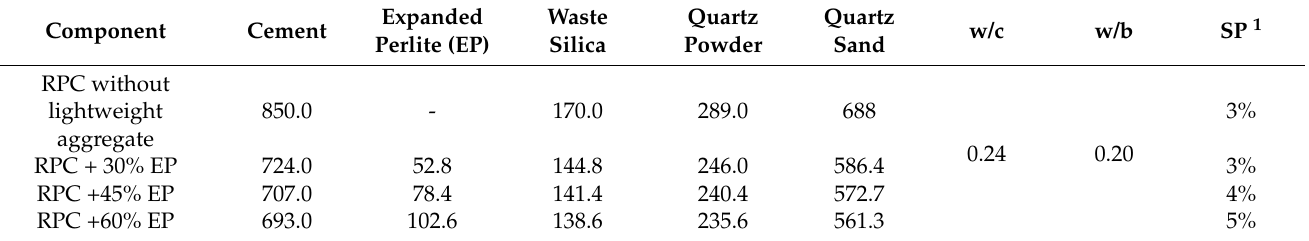
Table 2. Composition of RPC mix with expanded perlite (kg/m 3 ).